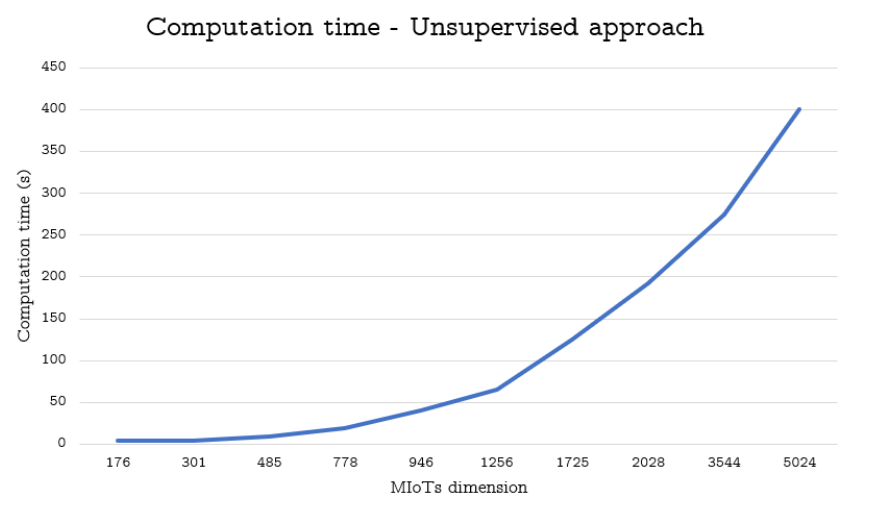
Figure 3. Computation time (in seconds) against the size of MIoTs (unsupervised